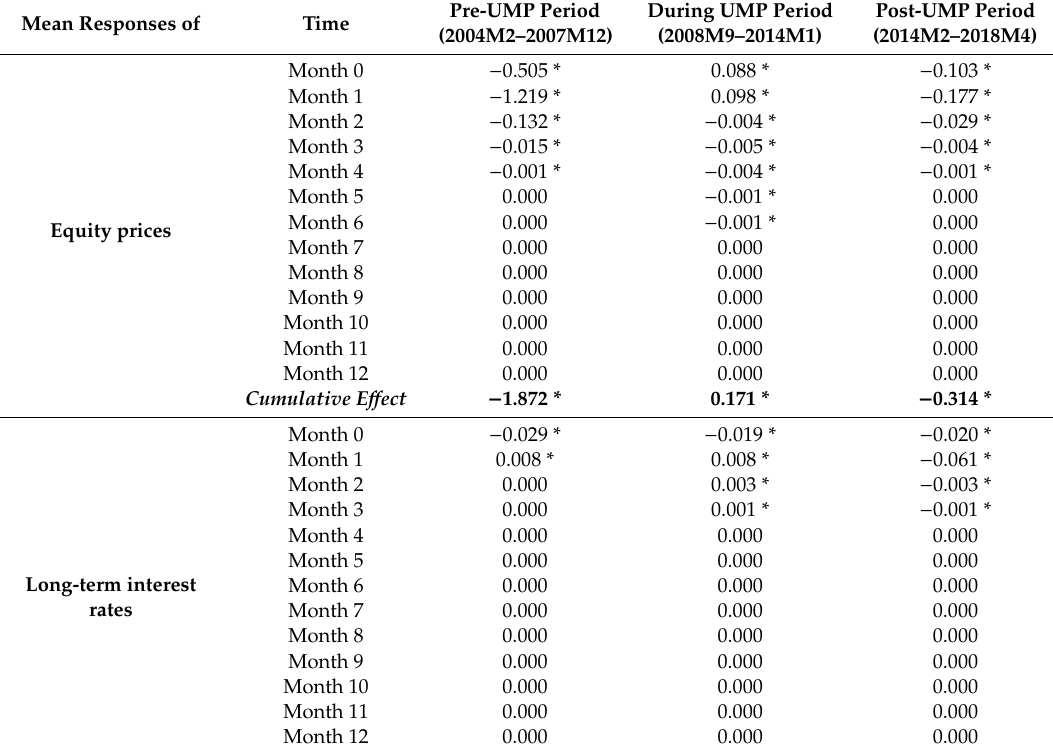
Table 6. Mean responses of asset prices to monetary policy shocks over three